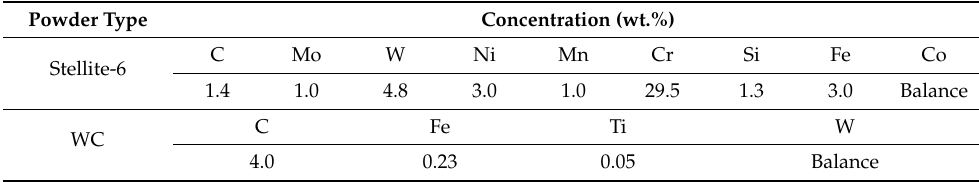
Figure 1. FESEM powder micrographs of ( a ) stellite-6 and ( b ) spherical tungsten carbides. Table 2. Chemical composition of the deposited powder